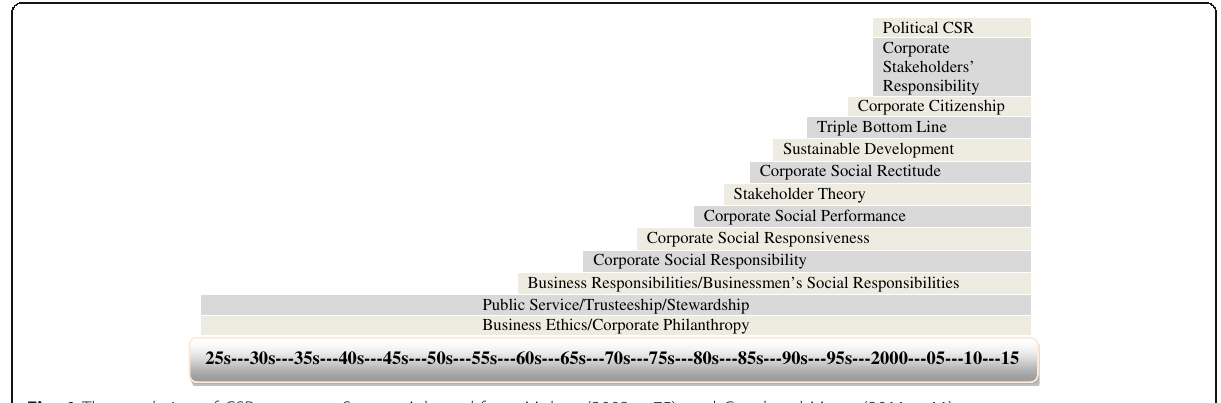
Fig. 1 The escalation of CSR concepts. Source: Adapted from Mohan (2003, p.75), and Gond and Moon (2011,